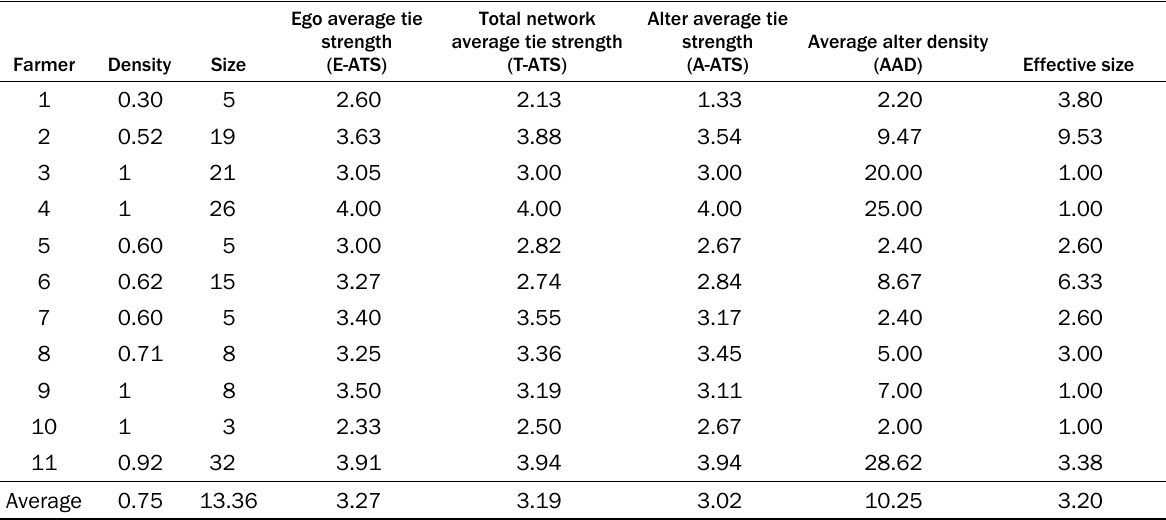
Table 3. Support Network